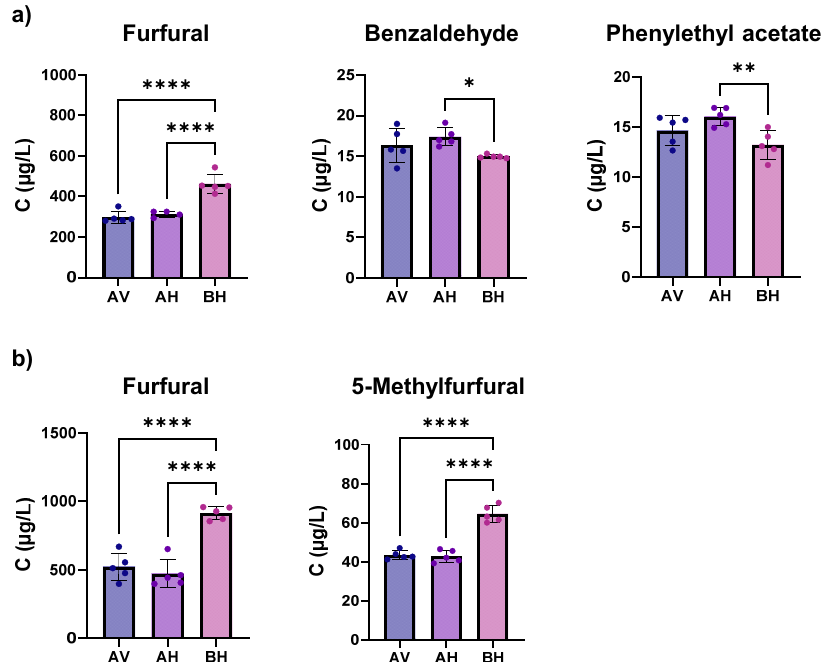
Figure 1. Boxplots illustrating the levels of volatile compounds present in Vintage Port wine that changed with the cellar conditions at ( a ) 15 months and ( b ) 44 months. AV—cellar A vertical position, AH—cellar A horizontal position, BH—cellar B horizontal position. *— p ≤ 0.05, **— p ≤ 0.01, ****— p ≤ 0.0001.